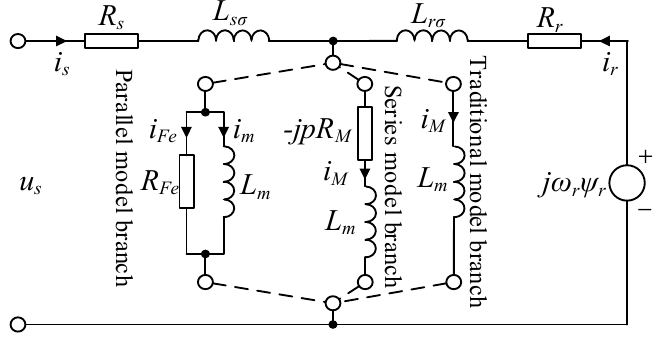
Figure 1. Transient equivalent circuits for parallel, series, and conventional model.